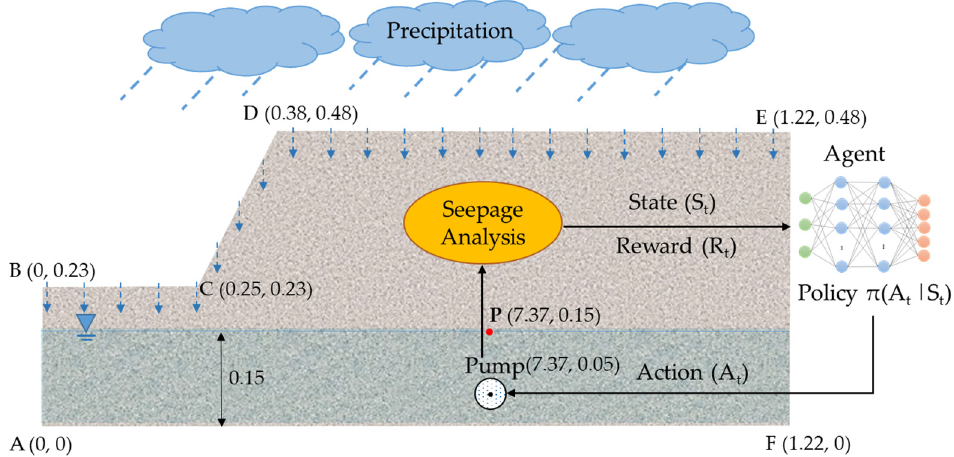
Figure 1. Agent–environment interaction in the geosystem; the virtual learning environment consists Figure 1. Agent – environment interaction in the geosystem; the virtual learning environment con- sists of a lab-scale slope equipped with a pump and subjected to precipitation (unit: m). of a lab‑scale slope equipped with a pump and subjected to precipitation (unit: m). The basic elements for RL in the geosystem are as The basic elements for RL in the geosystem are as follows.